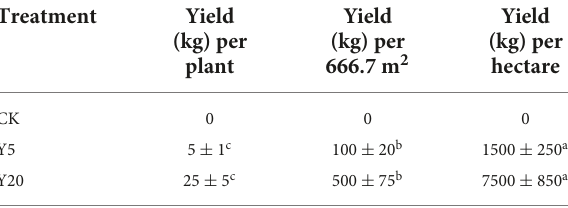
TABLE 2 Nut yield of M. integrifolia for all three monoculture cropping systems (CK = 1-year monoculture orchard, Y5 = 5-year monoculture orchard, and Y20 = 20-year monoculture